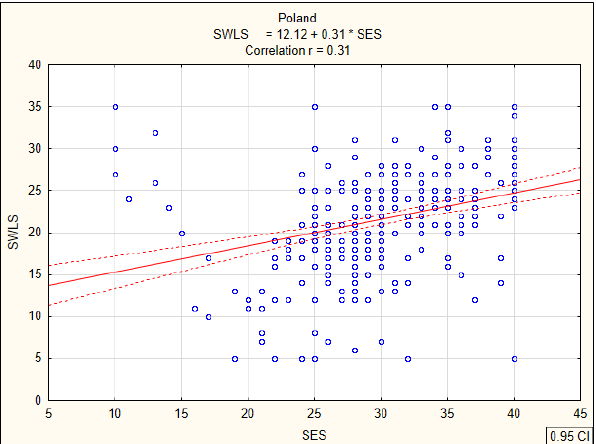
Figure 5. Correlation between global self-esteem according to SES and life satisfaction according to SWLS among Slovak students. Int. J. Environ. Res. Public Health 2020 , 17 , x